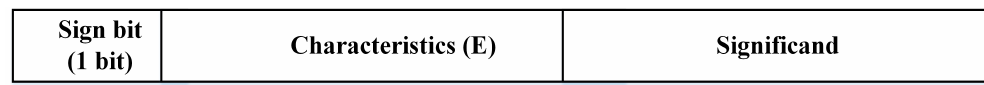
Figure 2. Floating-point representation.